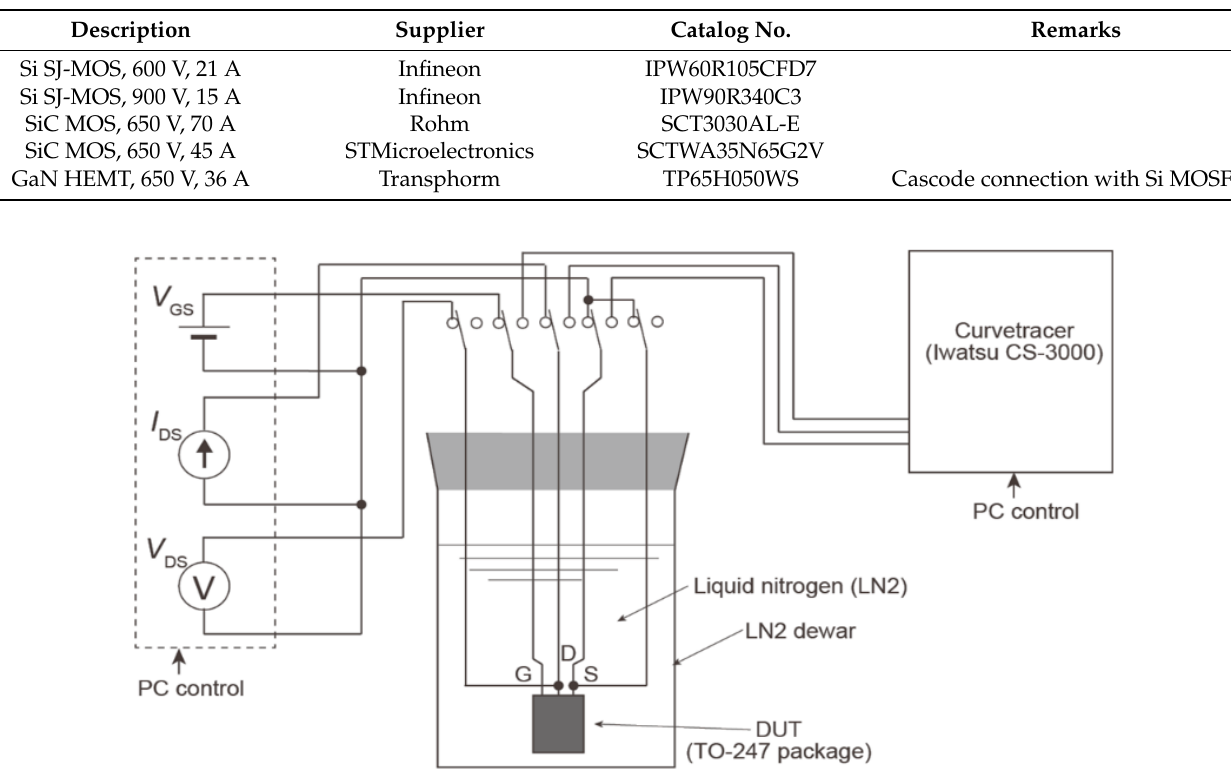
Figure 6. A schematic diagram of the experimental test setup.